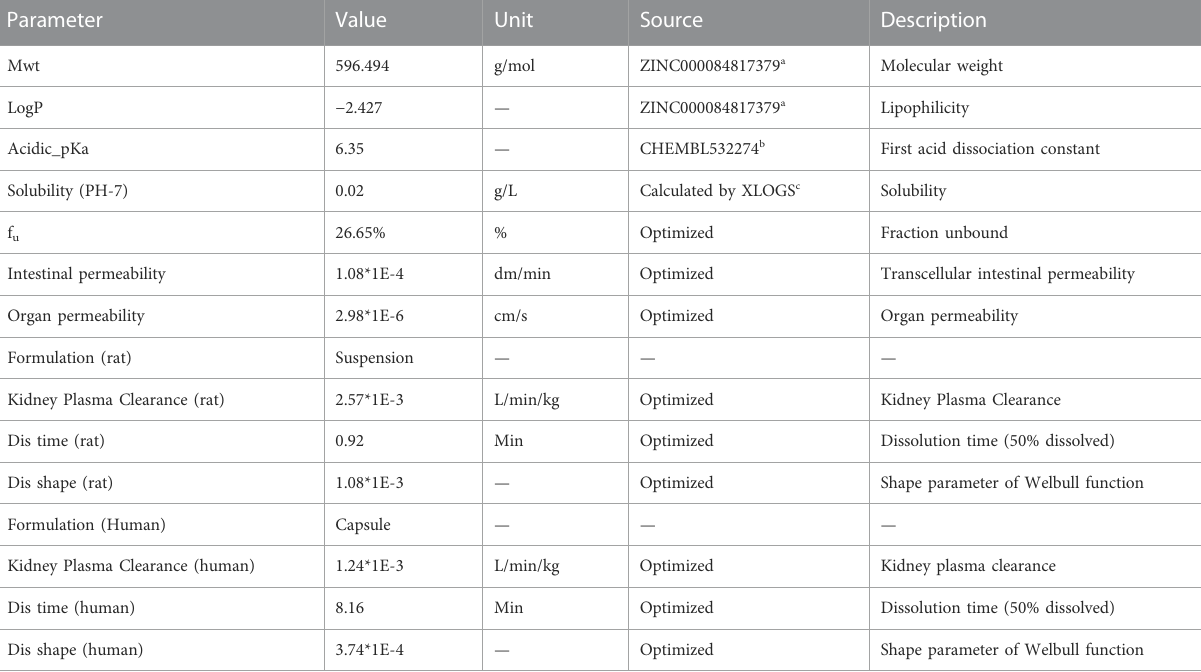
TABLE 1 Parameters used to establish the PBPK models of schaftoside in rat and human.